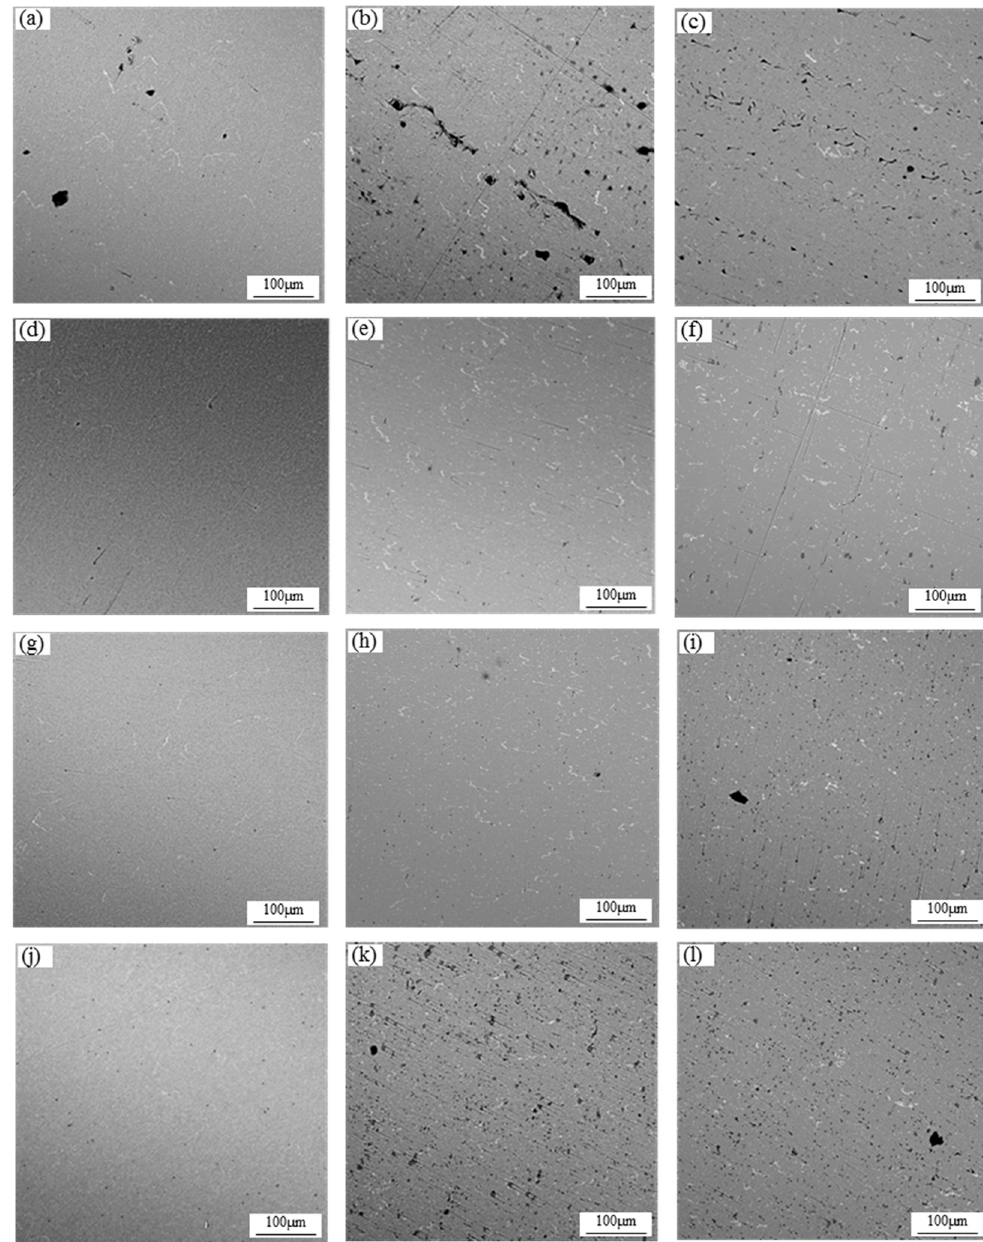
Figure 5. Precipitated phases of the 1060 aluminum alloy cast rolling strips: ( a–c ) the top surface, longitudinal section, cross section of the strip with added 0.18 wt% Al-Ti-B refiner and applied conventional treatment; ( d–f ) the top surface, longitudinal section, cross section of the strip with added 0.18 wt% Al-Ti-B refiner and applied ultrasonic treatment; ( g–i ) the top surface, longitudinal section, cross section of the strip with added 0.12 wt% Al-Ti-B refiner and applied ultrasonic treatment; ( j–l ) the top surface, longitudinal section, cross section of the strip with added 0.09 wt% Al-Ti-B refiner and applied ultrasonic treatment.